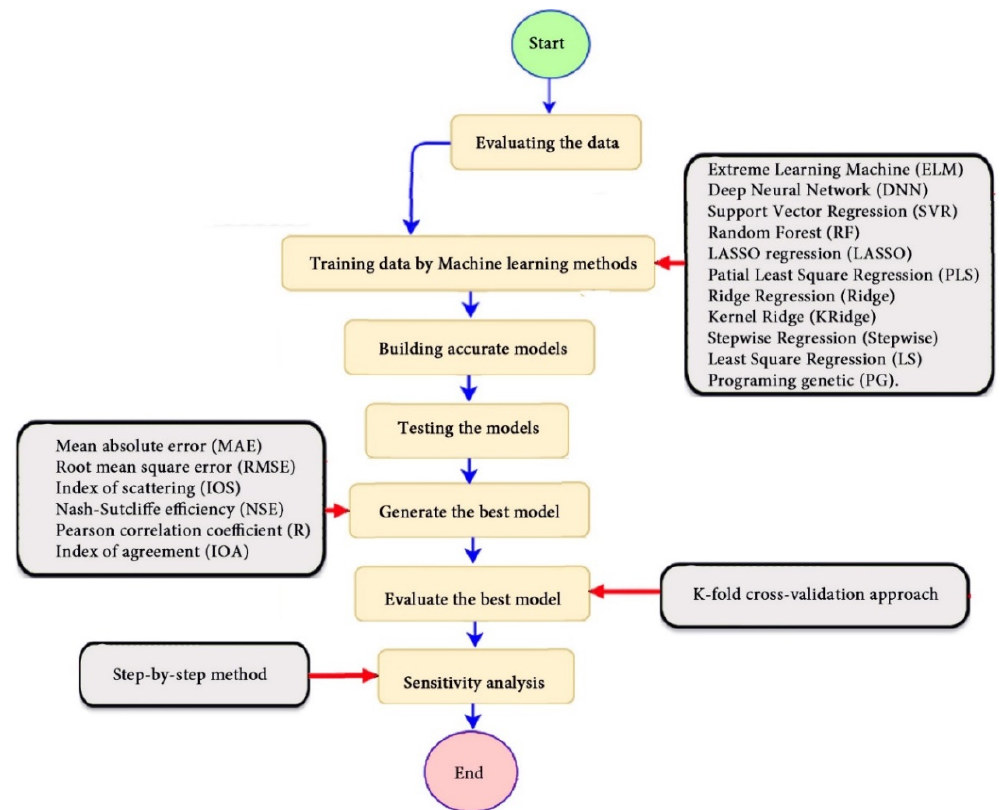
Figure 1. Flowchart describing the key steps for the methodology of research to estimate the pile-bearing capacity.